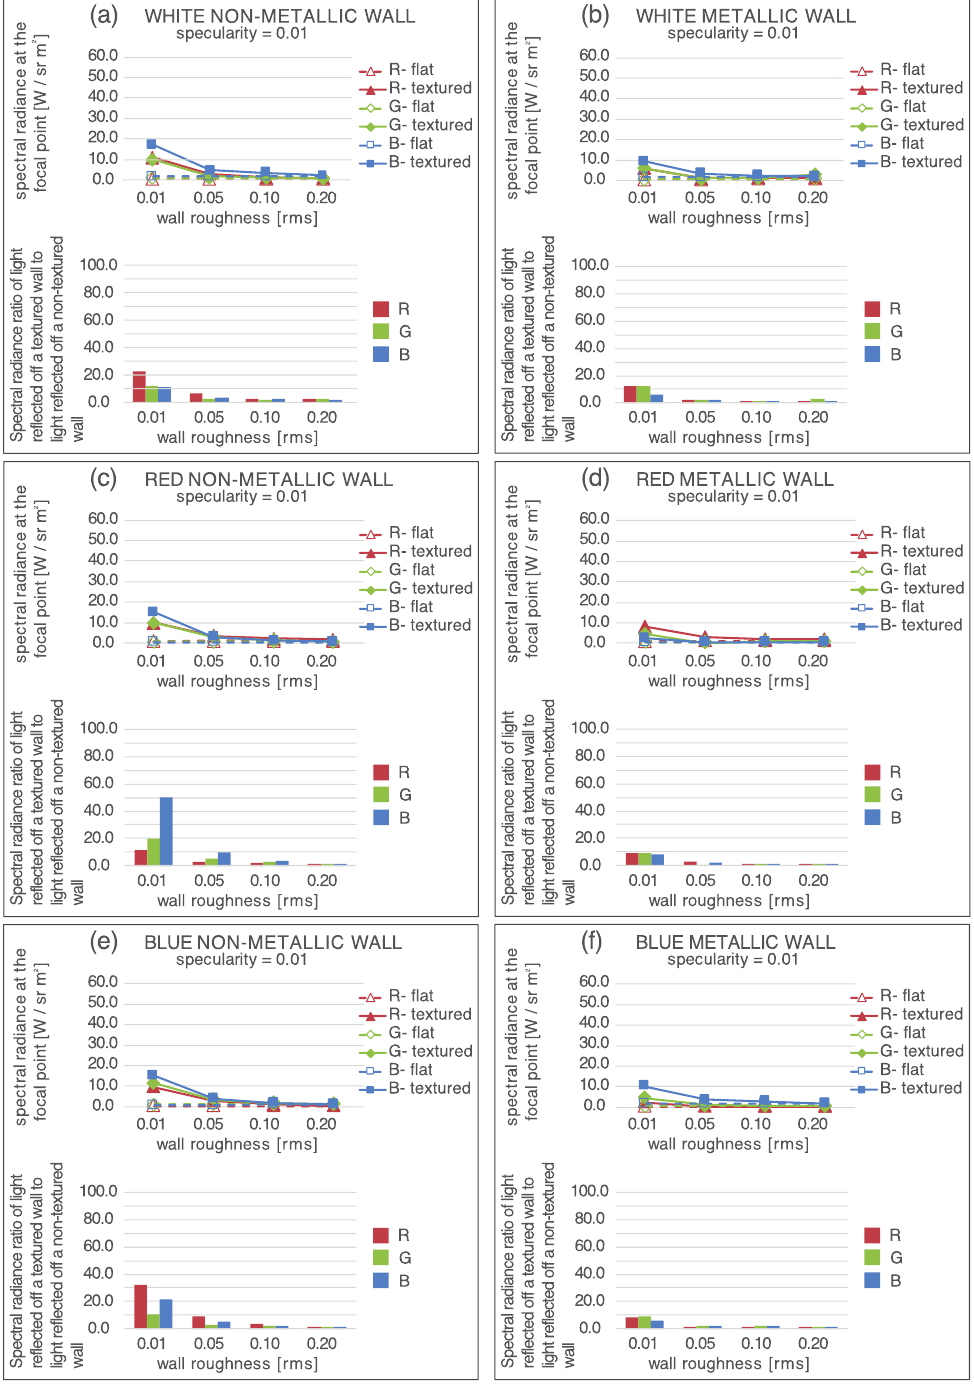
Figure 6. Spectral radiance values and spectral radiance ratios of light reflected off a textured active wall to light reflected off a non-textured active wall with a 0.01 specularity and a 0.01–0.20 range roughness.